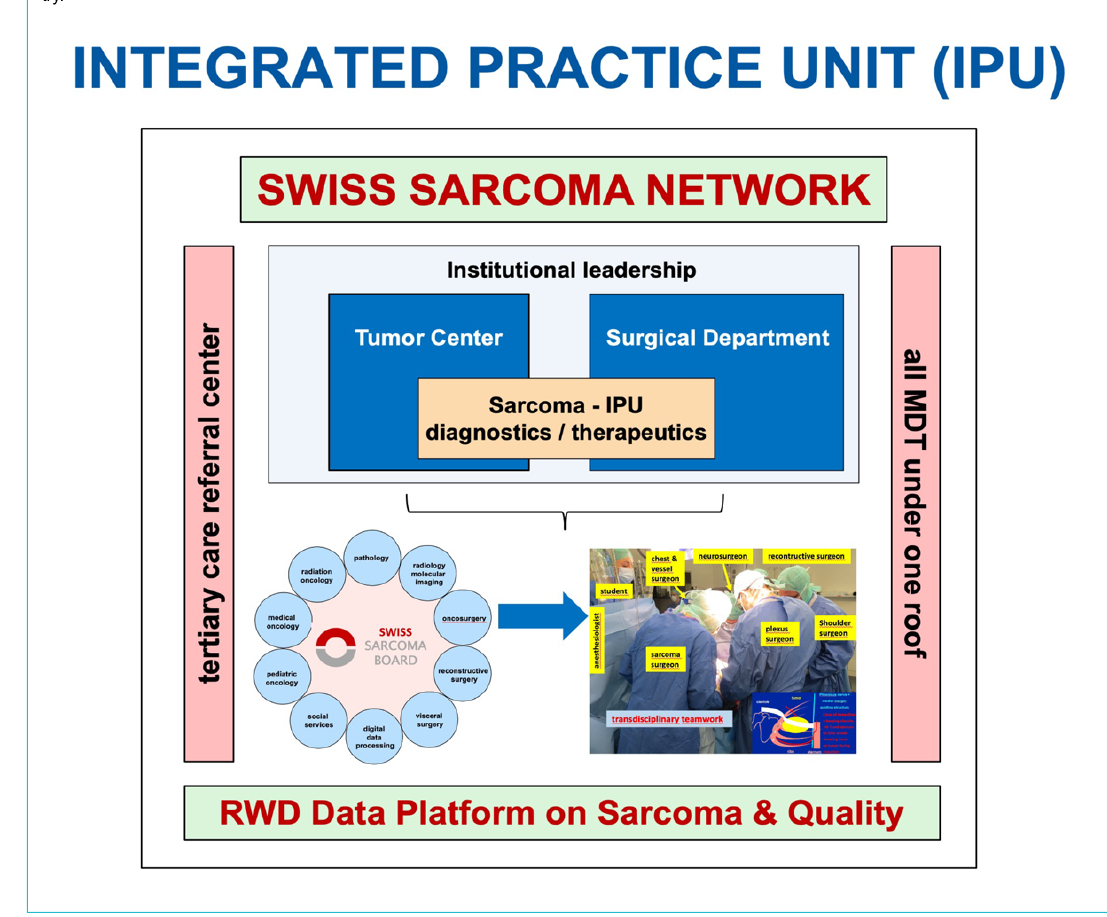
Figure 2: Sarcoma not being a discipline, the sarcoma IPU is built from the surgical transdisciplinary teams and the tumour centre with its as- sociated disciplines. Sharing a common information technology real-world data platform, the sarcoma IPUs can be scaled up across the coun-